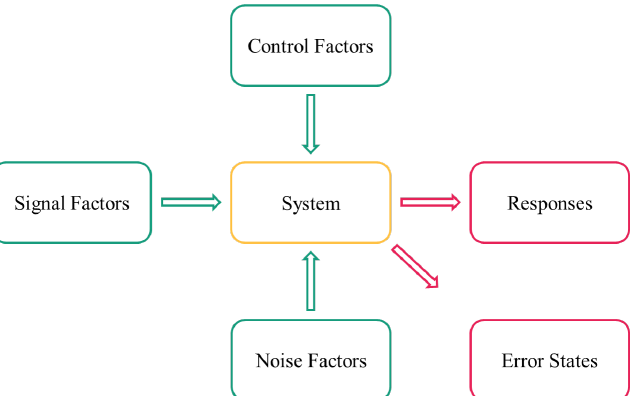
Figure 2. Parameter diagram. While control, signal, and noise factors affect the system, the responses and error states are the affected system’s output cf.